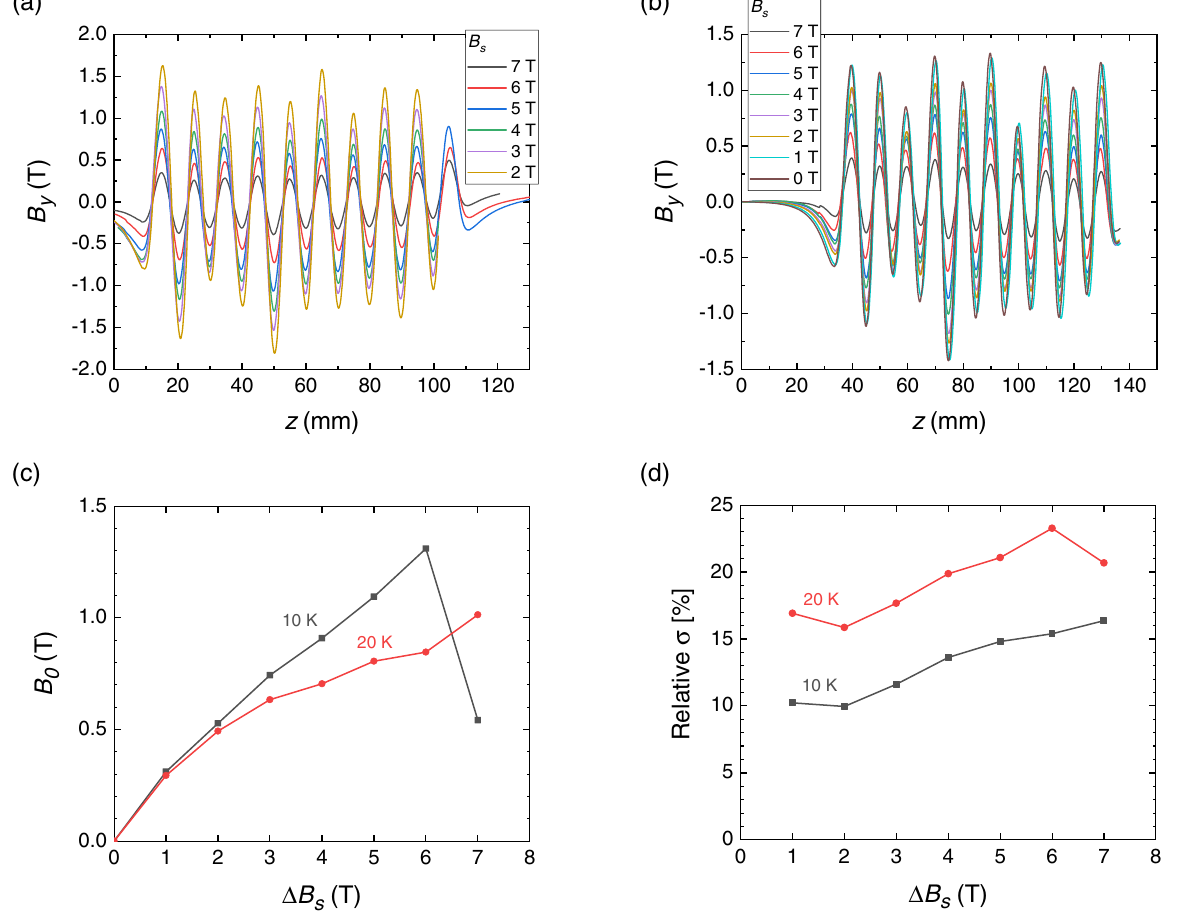
FIG. 7. Measured magnetic field B (a) 10 K and (b) 20 K; the relationship between (c) Δ B